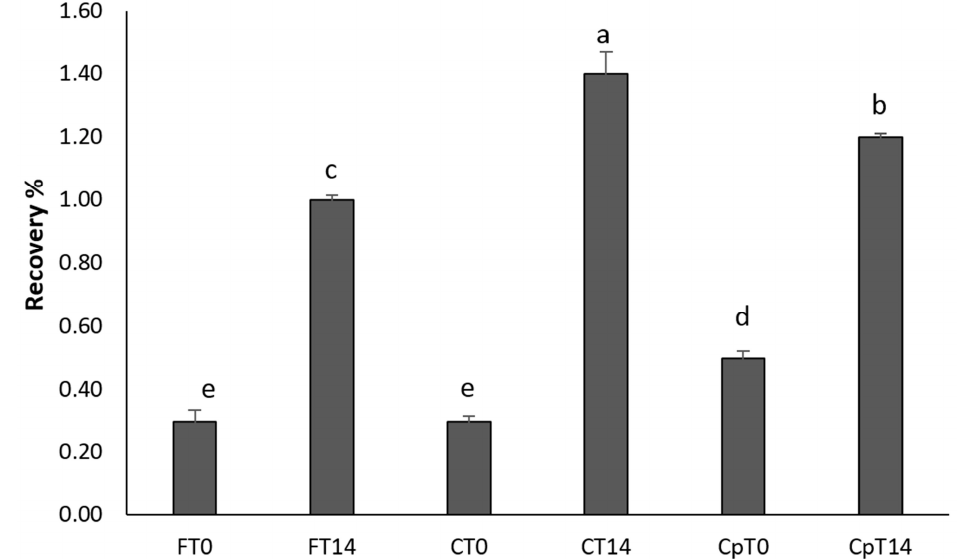
Figure 3. The combined recoveries of malvidin-3- O -glucoside from untreated and treated blueberry samples. Different letters indicate significant differences ( p < 0.05) between treatments, based on Tukey’s tests ( n = 3). F refers to uncoated samples, C to samples coated with chitosan and Cp to samples coated with chitosan and procyanidins. (T0) without storage and (T14) after storage for 14 days.